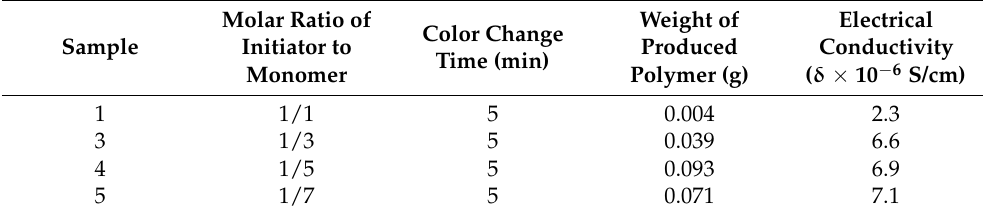
Table 2. Electrical conductivity of polycarbazole produced with different molar ratios of FeCl 3 (dry) initiator to monomer, with PTSA (1M) as the dopant in acetone and the absence of an electric field after 3 h. Electrical Weight of Molar Ratio of Color Change Conductivity Produced Sample Initiator to Time (min) ( δ × 10 − 6 S/cm) Polymer (g) Monomer 1/1